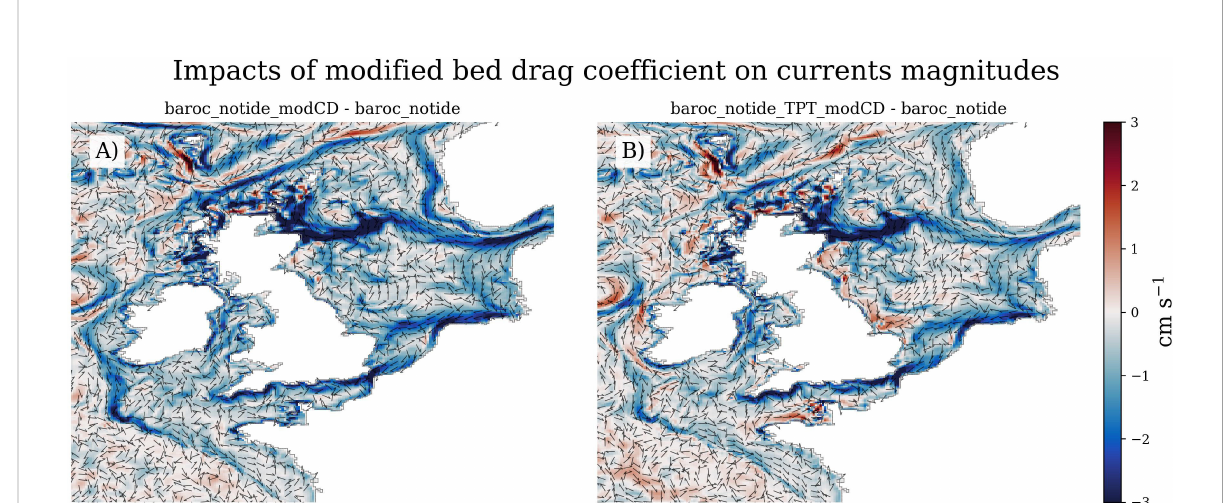
FIGURE 7 The impact the (A) modi fi ed bed drag coef fi cient tidal parameterisation has on the depth-mean current magnitudes (baroc_notide_modCD – baroc_notide) and (B) the impact of both the modi fi ed bed drag coef fi cient and TPT parameterisations (baroc_notide_TPT_modCD – baroc_notide). The colour denotes the change in residual current magnitude (cm s -1 ) and arrows give direction. Red shows where the current is faster in the tidal parameterisation simulation than in